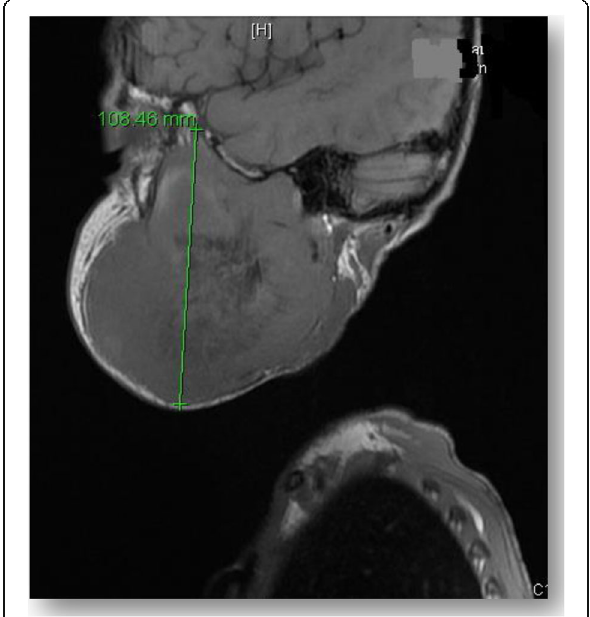
heterogeneous right mandibular soft tissue mass with extension into the infratemporal fossa (arrow)